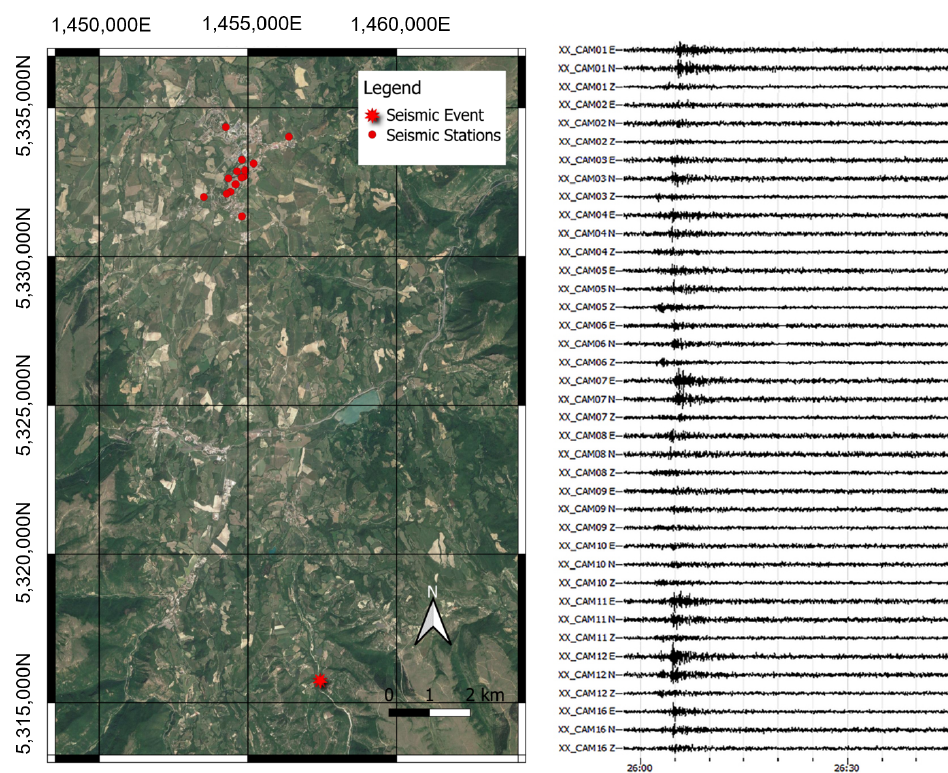
Figure 11. Position of the MEMS accelerometric stations with respect to the epicentre of ML 3.3 earthquake, which occurred near Fiordimonte (MC) on 18 April 2021 (left panel). Accelerometric waveforms recorded by MEMS accelerometric stations during the same earthquake (right panel).